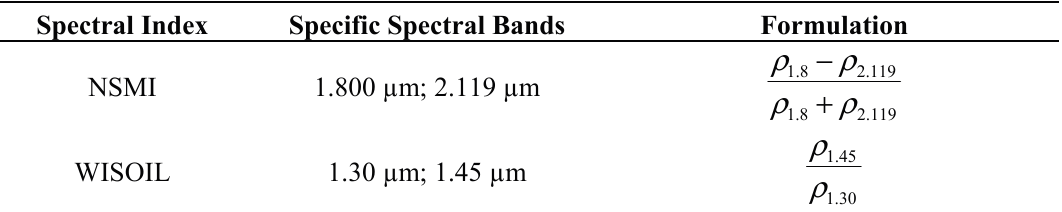
Table 3. Existing spectral indices suitable for SMC assessment ( ρ